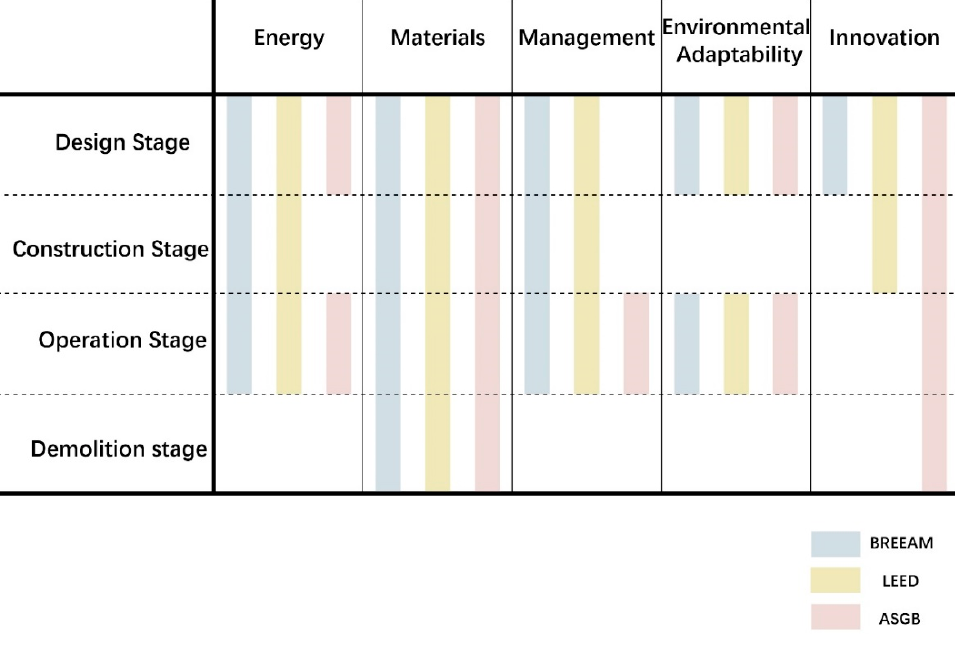
Figure 4. Implementation Involving Different Stages.